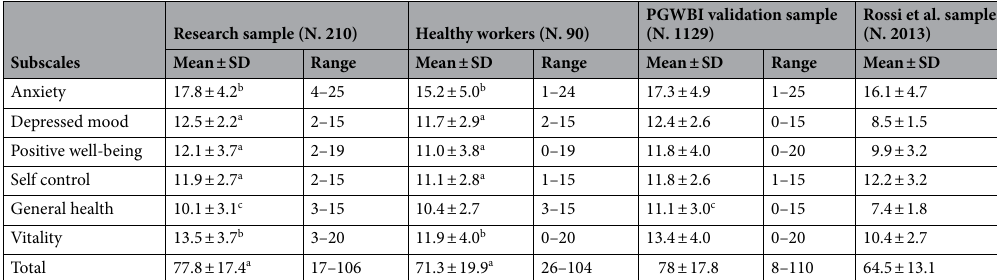
Table 2. PGWBI scores for each subscale in the study population, in the healthy workers, in the Italian population validation sample (Grossi et al., 2002) and in Rossi et al. (2021) population sample. Research sample vs healthy workers: a p < 0.01; b p < 0.001. Research sample vs PGWBI validation sample: c p < 0.001.